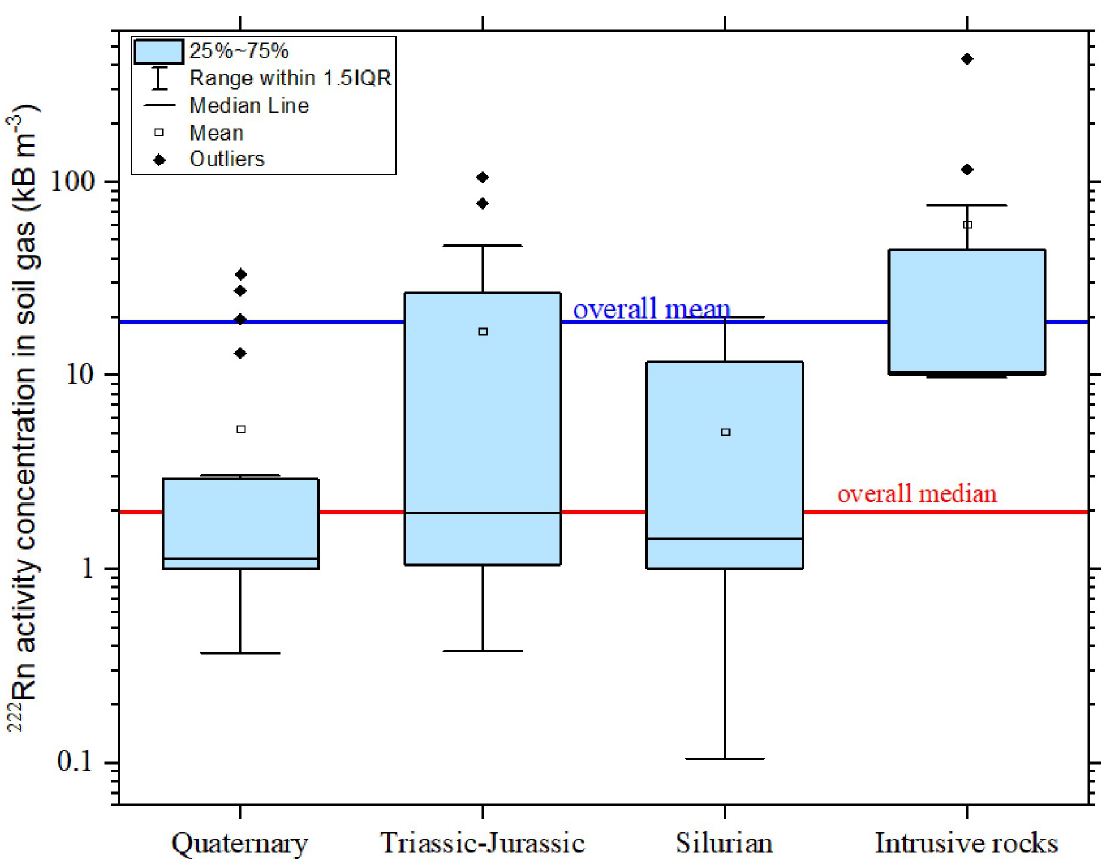
Fig 4. Box plot of radon activity concentration in geological formations of Perak state.